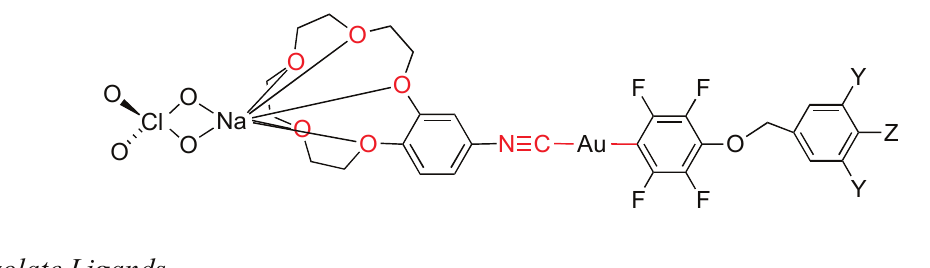
Figure 20. Sodium adduct of crown ether isocyanide gold compound. Y = H, Z = OC Y = Z = OC H 8 17